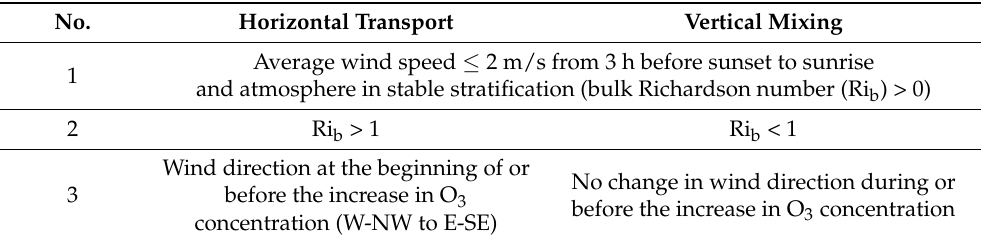
Table 2. Criteria for nighttime O 3 pollution transport